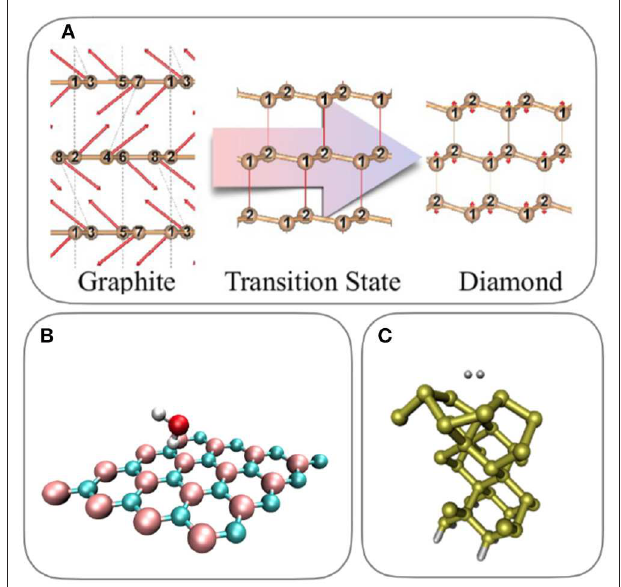
FIGURE 2 | Overview of recent PAW-based periodic coupled cluster theory calculations: (A) pressure-driven phase transition from carbon graphite to diamond ( Gruber and Grüneis, 2018), (B) water adsorption on an h ( Gruber et al., 2018), and (C) dissociative hydrogen molecule adsorption on the Si(100) surface ( Tsatsoulis et al.,